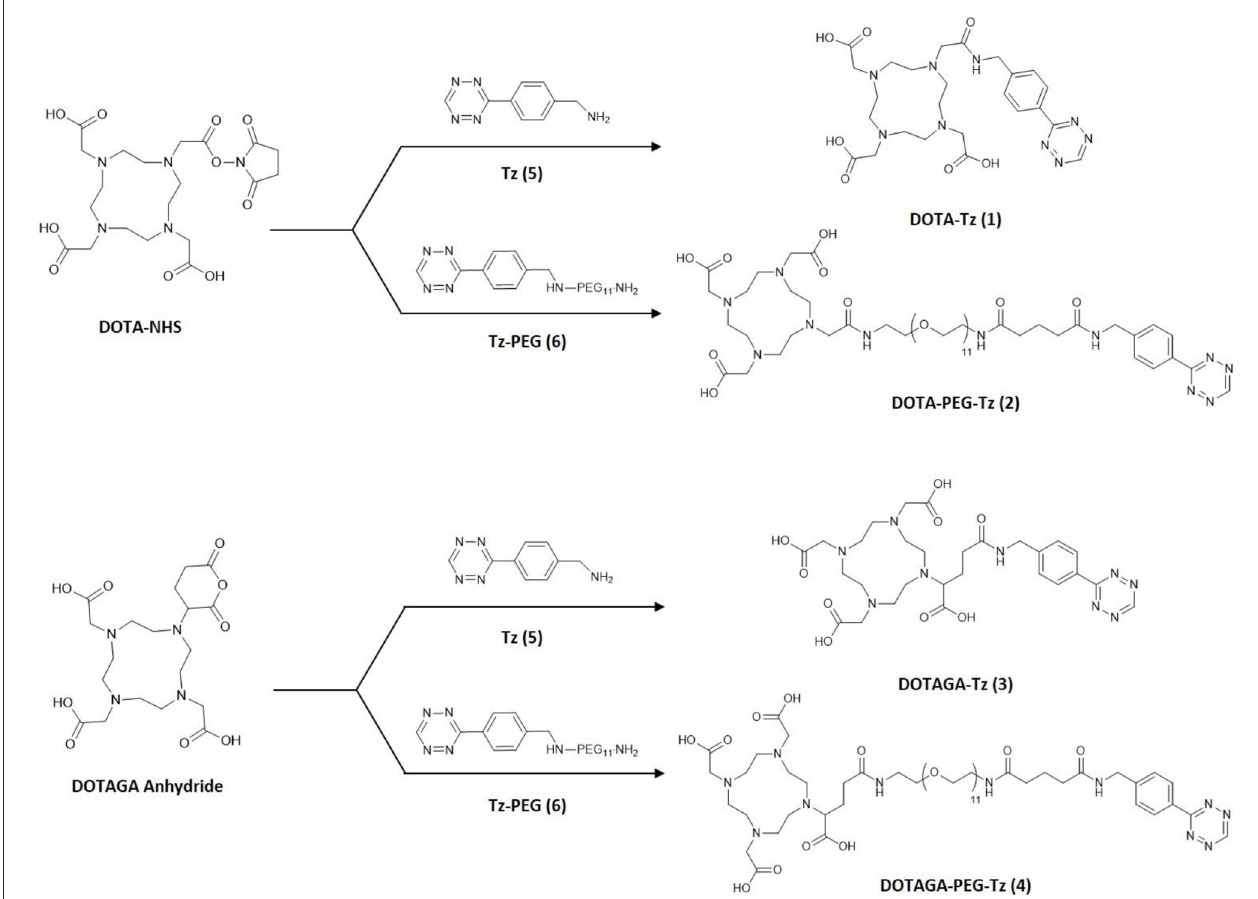
FIGURE 1 | The clickable chelators DOTA-Tz (1) , DOTA-PEG-Tz (2) , DOTAGA-Tz (3) and DOTAGA-PEG-Tz (4) synthesized by coupling the commercially available DOTA-NHS and DOTAGA anhydride with the clickable precursors Tz (5) and Tz-PEG (6) .